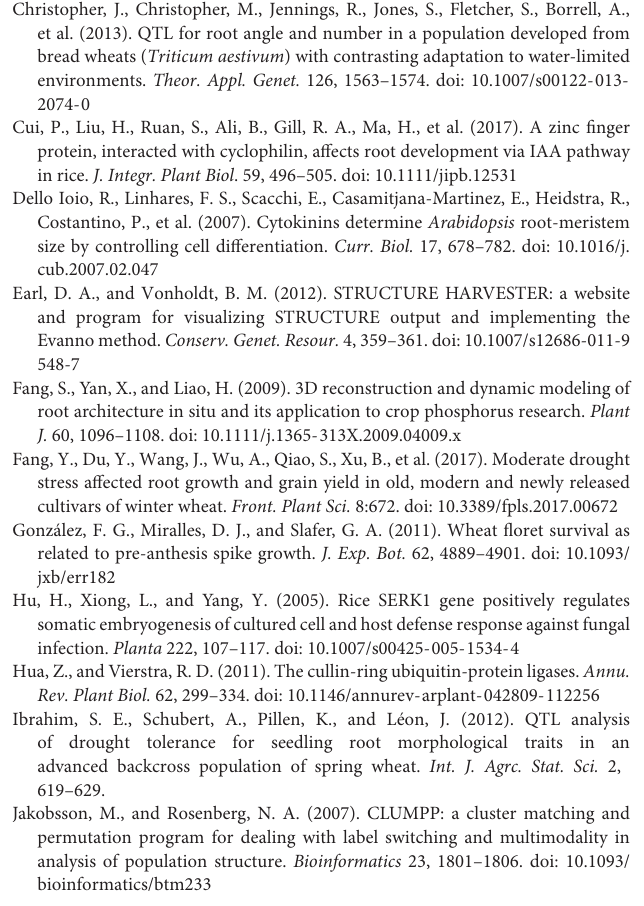
Supplementary Table 2 | Difference of root traits among OHC, IHC, and OPC at seedling stage. Supplementary Table 3 | Correlation coefficients of root traits under different growing environments. Supplementary Table 4 | GWAS results for root traits according to the mixed linear model. Supplementary Table 5 | Genetic positions of SNPs in co-localization associated with root traits under different growing environments. Supplementary Table 6 | Physical positions and associated traits of the pleiotropic SNP markers from different growing environments.